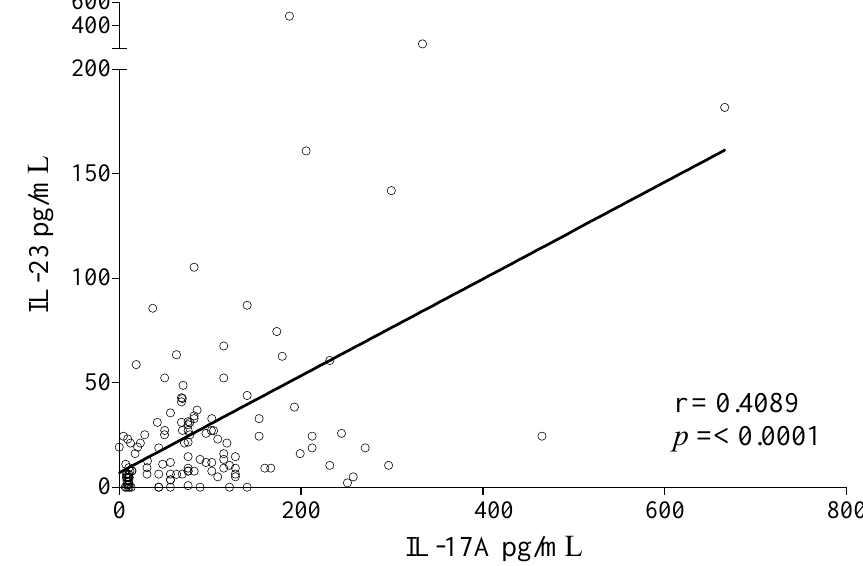
Figure 4. Serum levels of IL-17A and IL-23 are correlated during the clinical course of dengue infection. A positive correlation was found between IL-17A and IL-23 levels (r = 0.4089, p = < 0.0001) in patients with DENV infection ( n = 128). Statistical difference is based on Spearman’s correlation test.